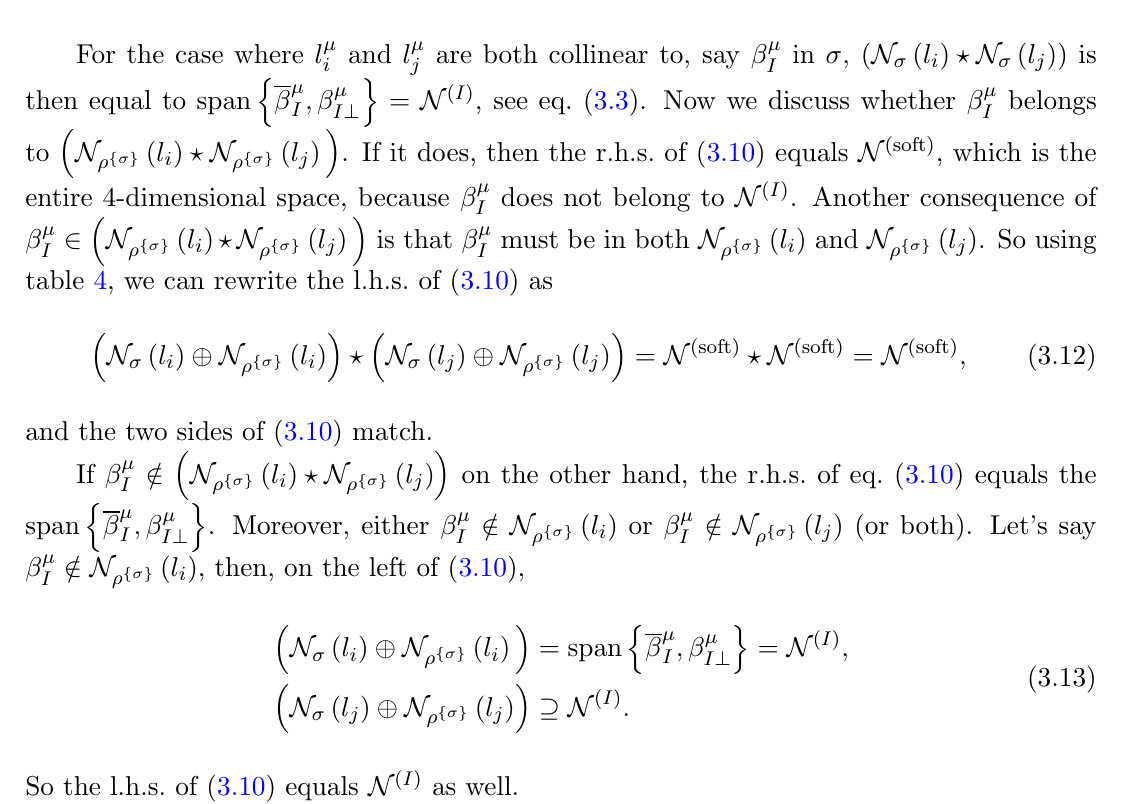
Figure 21. The three cases where one of the loop momenta l (cid:22) nontrivially by the approximations of t (cid:27)